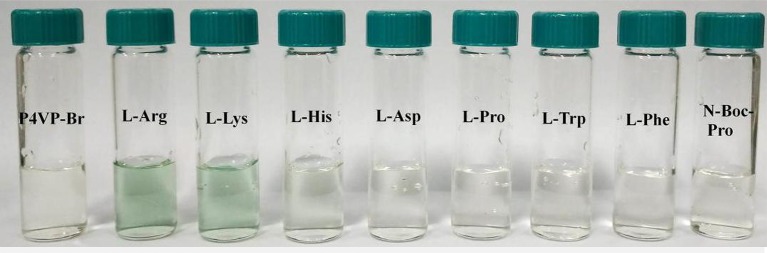
Photographic images of P4VP1-Br2 water solutions containing different amino acids.